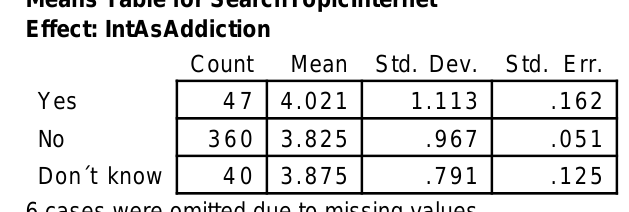
Means Table for